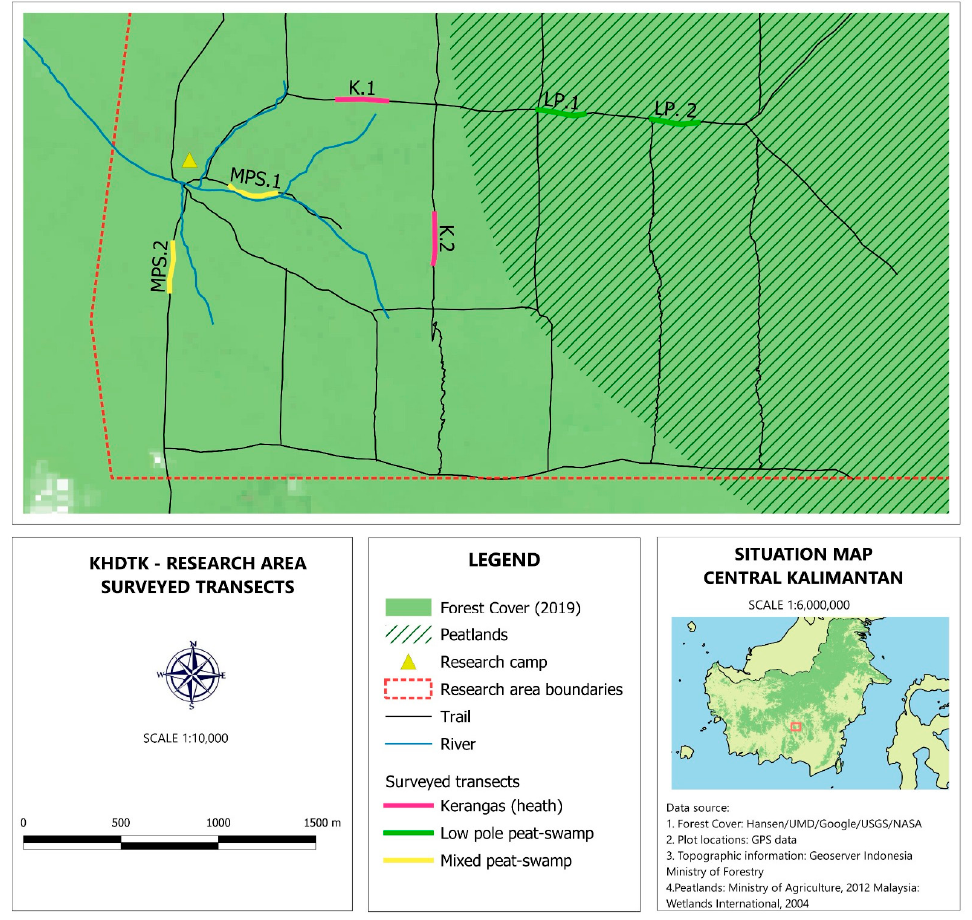
Figure 1. An overview of the established transect structure in the Mungku Baru Education Forest (Kawasan Hutan Dengan Tujuan Khusus), Central Kalimantan, Indonesia. Transects locations used for Odonata surveys are shown in respective colours: yellow—mixed peat swamp (MPS), red—kerangas (heath) (K), and green—low pole peat swamp (LP). Map provided by The Borneo Nature Foundation.